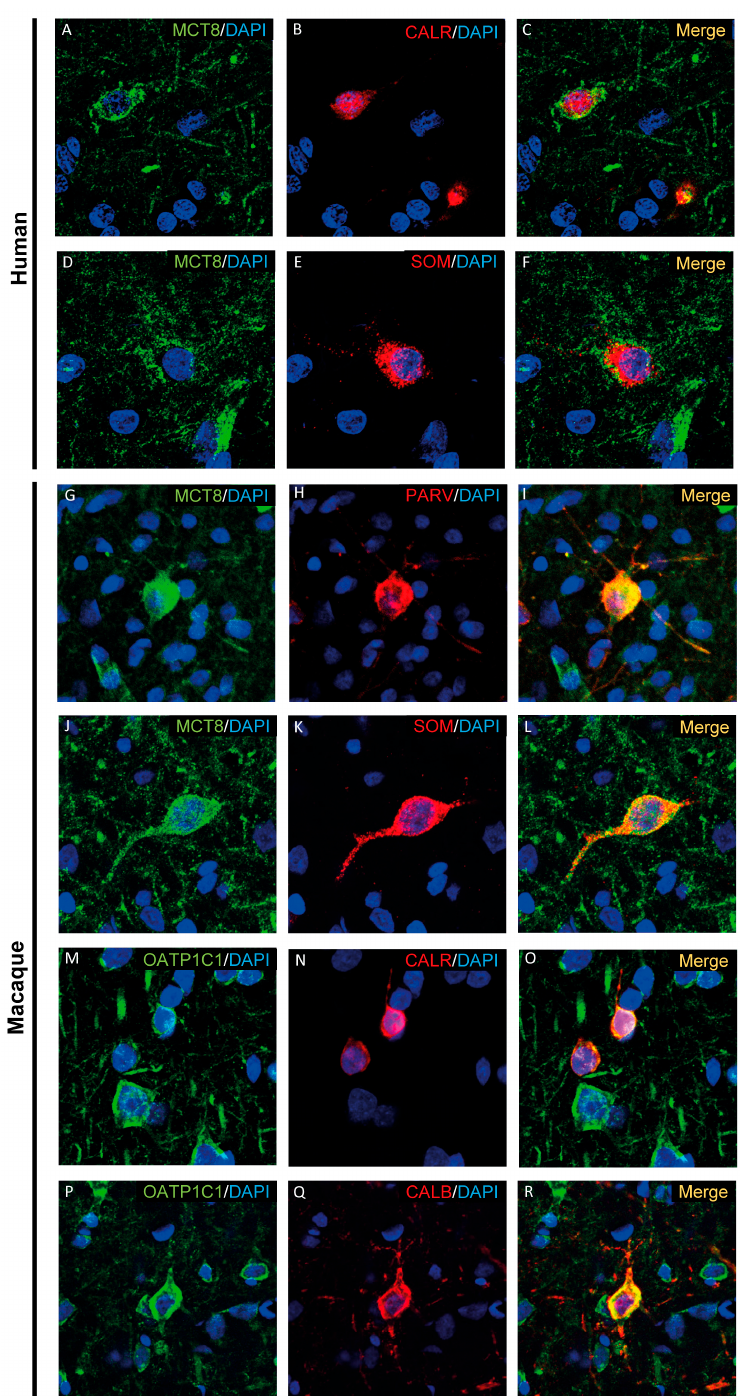
Figure 6. Expression of MCT8 and OATP1C1 in different subpopulations of GABAergic interneu- rons. Representative confocal microscope images of human ( A – F ) and macaque ( G – R ) cortical sections double-stained for MCT8 or OATP1C1 and several interneuronal markers. ( A – C ) Coex- pression of human MCT8 (green) with CALR (red). ( D – F ) Coexpression of human MCT8 (green) with SOM (red). ( G – L ) Colocalization of macaque MCT8 (green) with PARV (red, G – I ) and SOM (red, J – L ). ( M – R ) Colocalization of macaque OATP1C1 (green) with CALR (red, M – O ) and CALB ( P – R ). Counterstaining with DAPI (blue) shows nuclei of all cells. CALB: Calbindin-D-28K, CALR: calretinin, PARV: parvalbumin, SOM: somatostatin. Scale bar = 50 µ